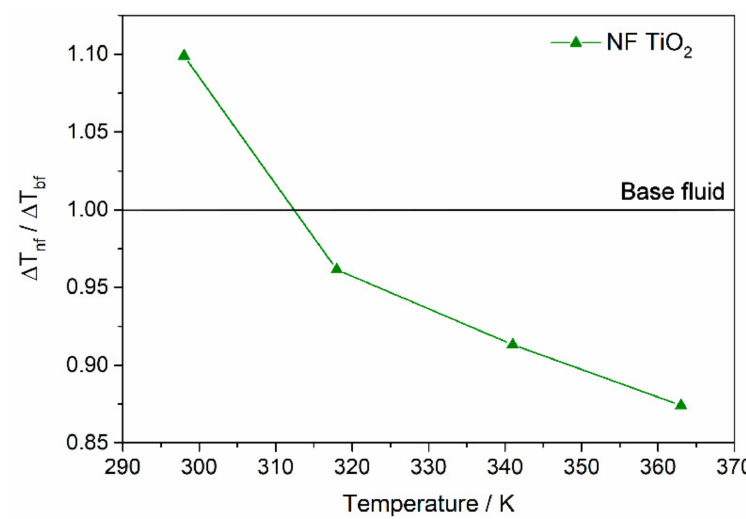
Figure 11. Outlet temperature in the solar collectors if nanofluids are